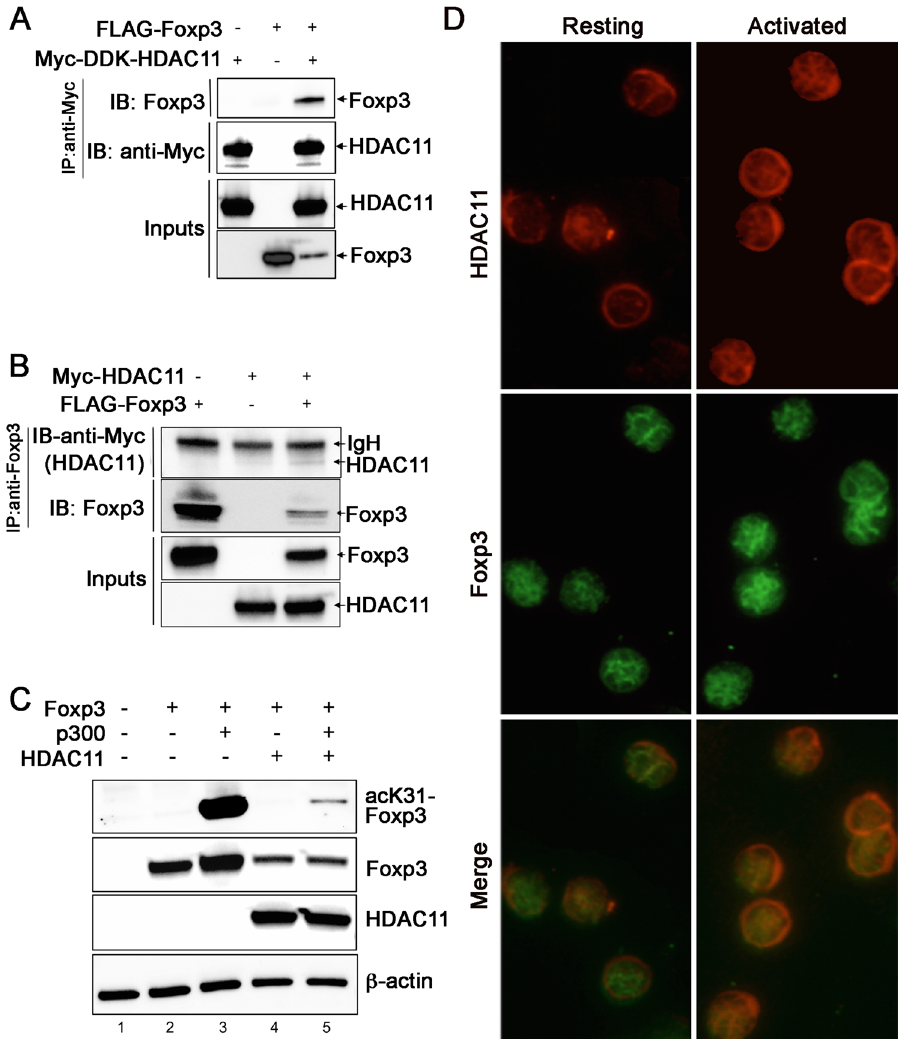
Figure 1. HDAC11 can associate with, and deacetylate, Foxp3. ( A ) Co-immunoprecipitation of Foxp3 protein when HDAC11 is immunoprecipitated from 293 T cells transfected with FLAG-tagged Foxp3 and Myc-tagged Hdac11; original uncropped gels are shown in Supplementary Fig. 1. ( B ) Co-immunoprecipitation of HDAC11 protein when Foxp3 is immunoprecipitated from 293 T cells transfected with FLAG-tagged Foxp3 and Myc- tagged HDAC11; original uncropped gels are shown in Supplementary Fig. 2. ( C ) Western blots showing that the acetylation of lysine-31 (K31) of Foxp3 by p300 (lane 3) is reversed by the presence of HDAC11 (lane 5); original uncropped gels are shown in Supplementary Fig. 3. ( D ) Detection of HDAC11 (nucleus and cytoplasm) and Foxp3 (nucleus) in resting Tregs, whereas CD3/CD28 mAb activation promotes their nuclear co-localization (original magnifications ×